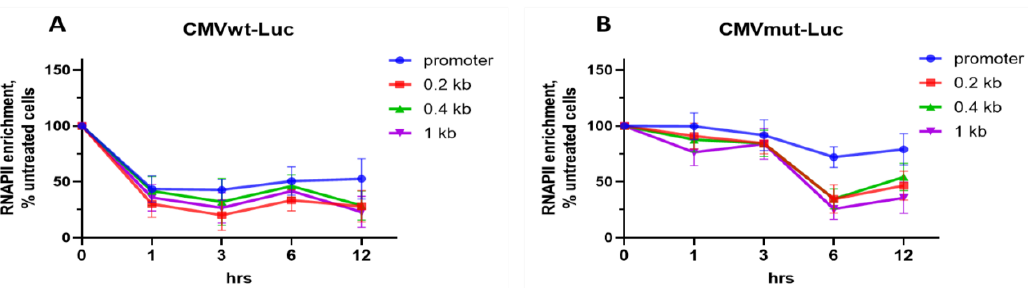
Figure 4. OA modulates the abundance of molecules depending on promoter GC context. HEK293T- CMVwt-Luc ( A ) or HEK293T-CMVmut-Luc ( B ) cells were treated with 100 nM OA for indicated time intervals followed by ChIP assays (see Section 3). Shown are enrichments in total RNAPII molecules on the Luc promoter and on CDS. RNAPII enrichment in untreated samples (0 h, input) was taken as 100%. Data are mean ± SD of two independent experiments, each value measured in triplicate.